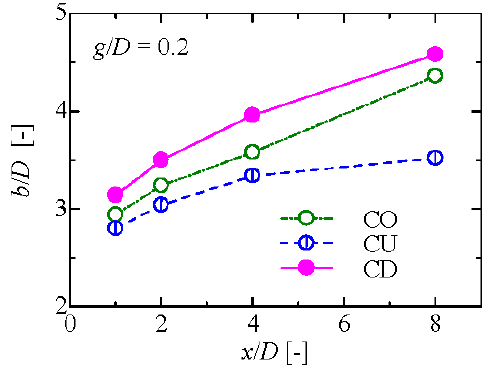
Figure 12. Streamwise variation of wake width obtained using CFD results by Hara et al.